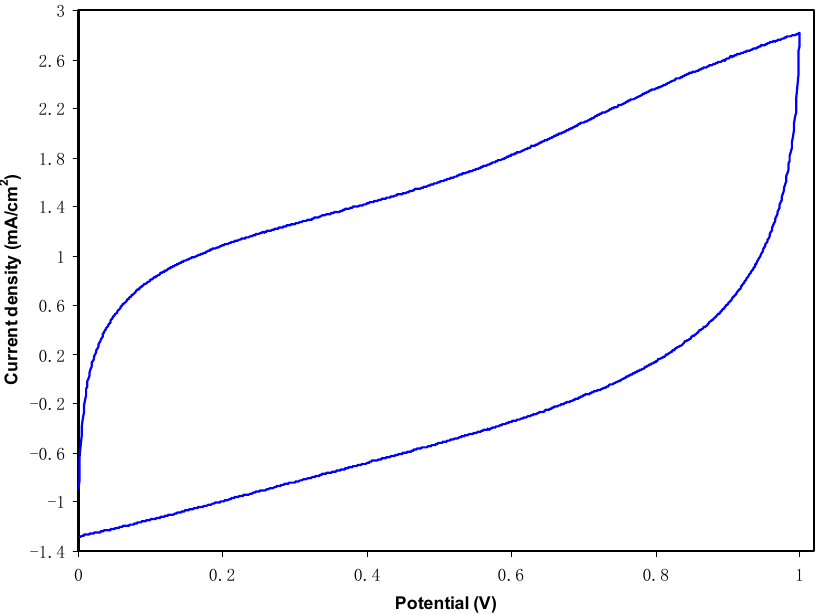
Figure 10. CV plot of the fabricated EDLC in the potential range of 0 V to 1 V.